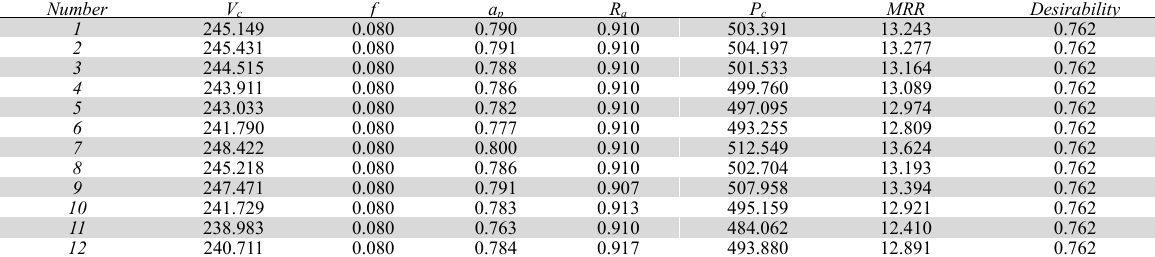
Responses for Ra, Fc, Pc and MRR for optimization of cutting